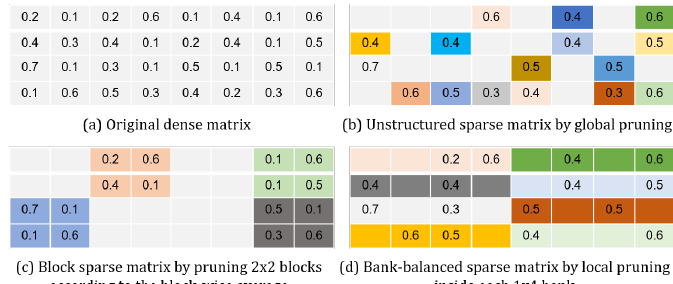
Figure 2. The existing pruning methods illustrated by examples.